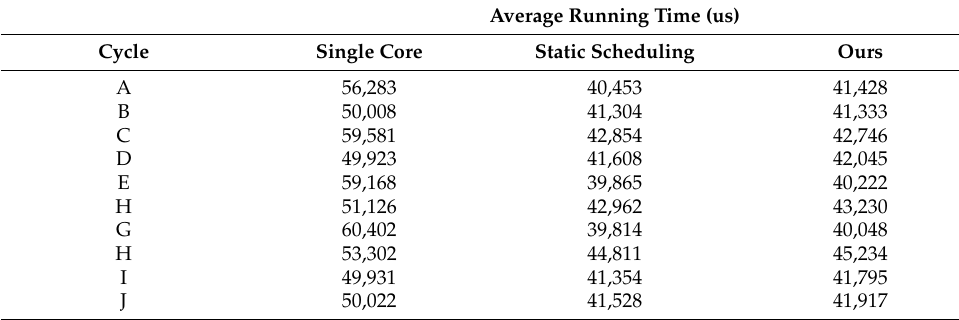
Table 6. Running time comparison for performance